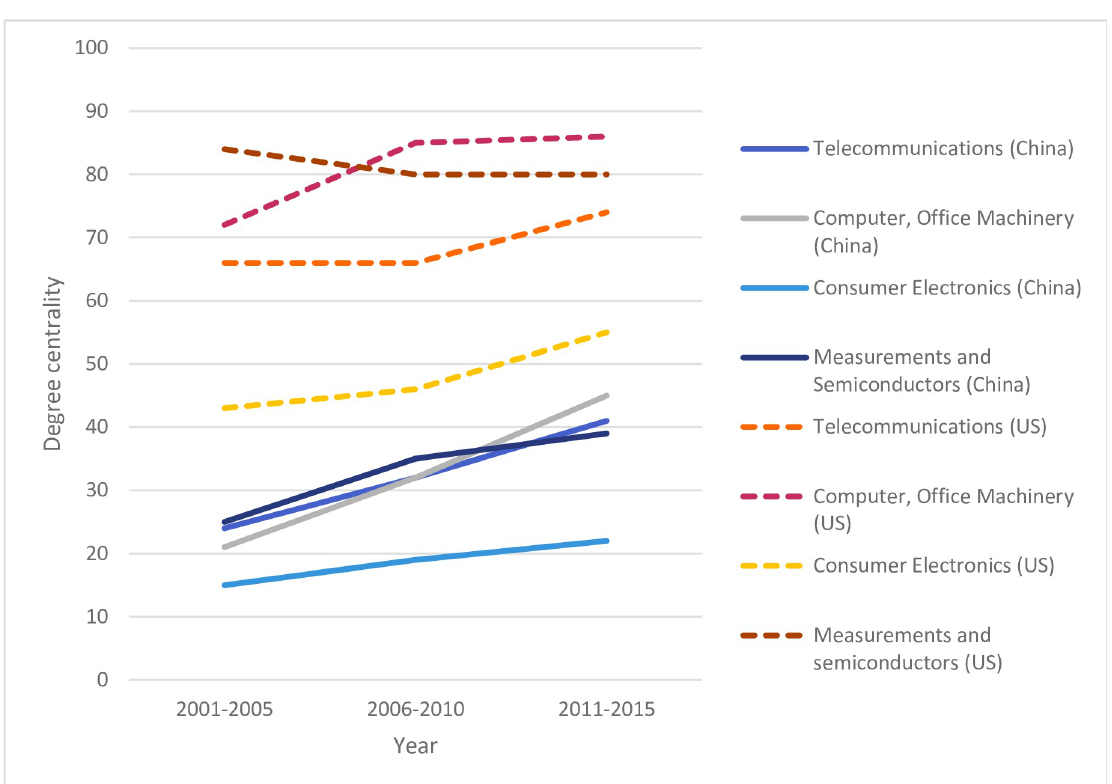
Fig 3. Degree centrality of US and China in the global ICT network (2001–2015).